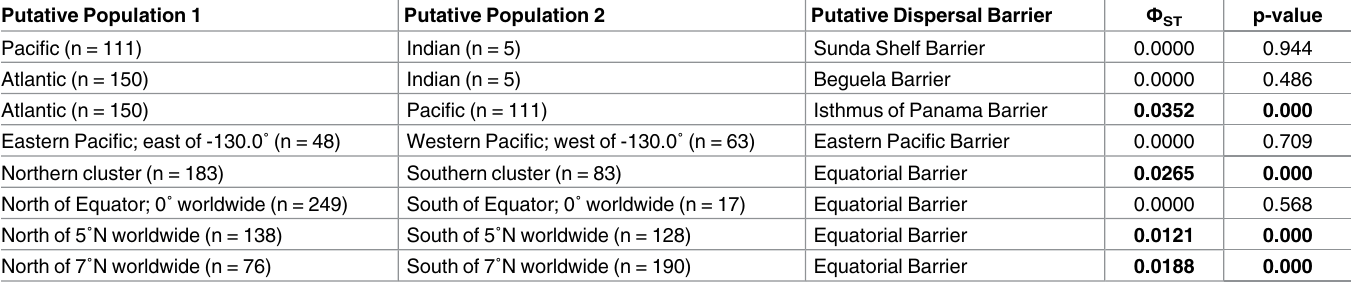
Table 2. Results of analysis of molecular variance (AMOVA) for cytochrome b sequence data between putative populations of Exocoetus voli- tans . Collectionlocalities, numbers of individuals (n), putative dispersalbarriers, Φ ST values, and p-values are listed. Significantresults are highlightedin bold and any negative Φ ST values were set to zero.